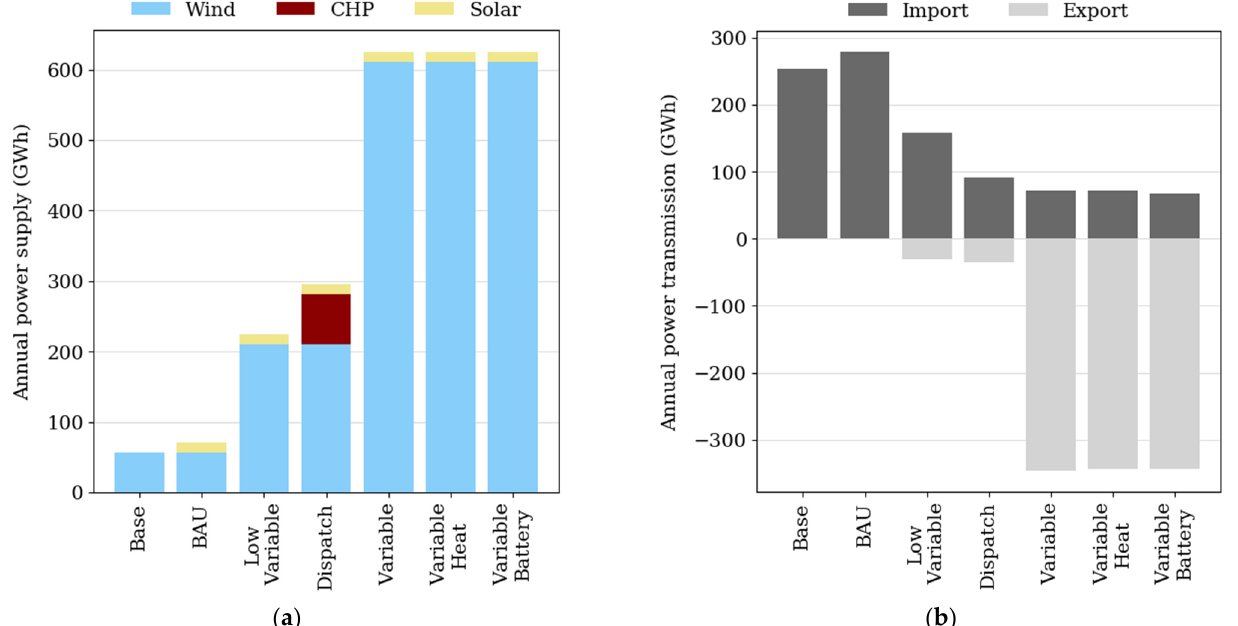
Figure 1. Simulated power sector operation of the different scenarios: ( a ) unit power production and ( b ) system electricity Figure 1. Simulatedpowersectoroperationofthedifferentscenarios: ( a )unitpowerproductionand( b )systemelectricity transmission.